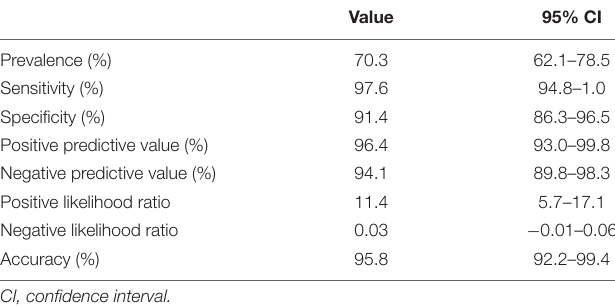
TABLE 3 | Evaluation of Airgo TM performance vs. Nox T3 in classifying OSA occurrence ( n = 118).